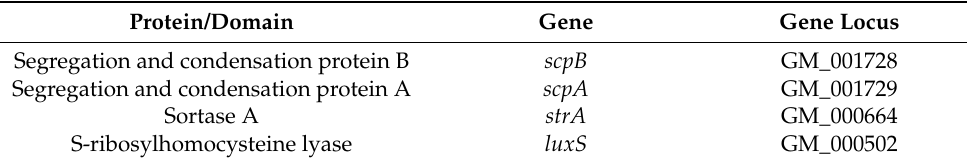
Table 5. Cell adhesion-associated proteins in the E. faecium FUA027 genome. Protein/Domain Gene Gene